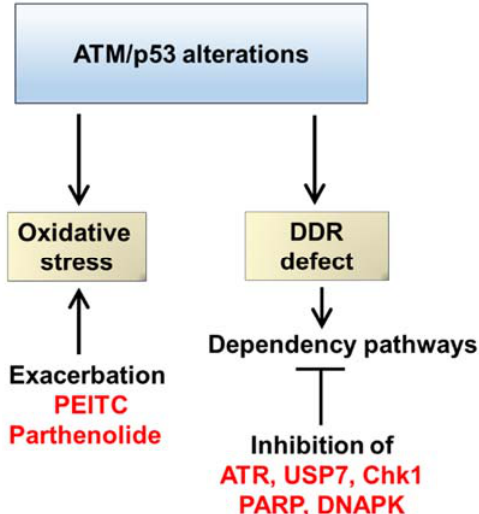
Figure 3. Exploiting cellular vulnerabilities induced by a defective p53 pathway. Alterations in the p53 pathway abrogate response to cellular stress. As a consequence, p53- or ATM-defective cells are sensitive to oxidative-stress-inducing agents such as PEITC or parthenolide. Abrogation of DNA damage response (DDR) leads to a number of cellular dependencies (addictions) in which tumor cells rely upon alternative pathways to repair DNA damage. Consequently, inhibition of these dependency pathways (i.e., ATR, USP7, PARP, or DNA-PK) leads to selective killing of p53 pathway-defective cells.